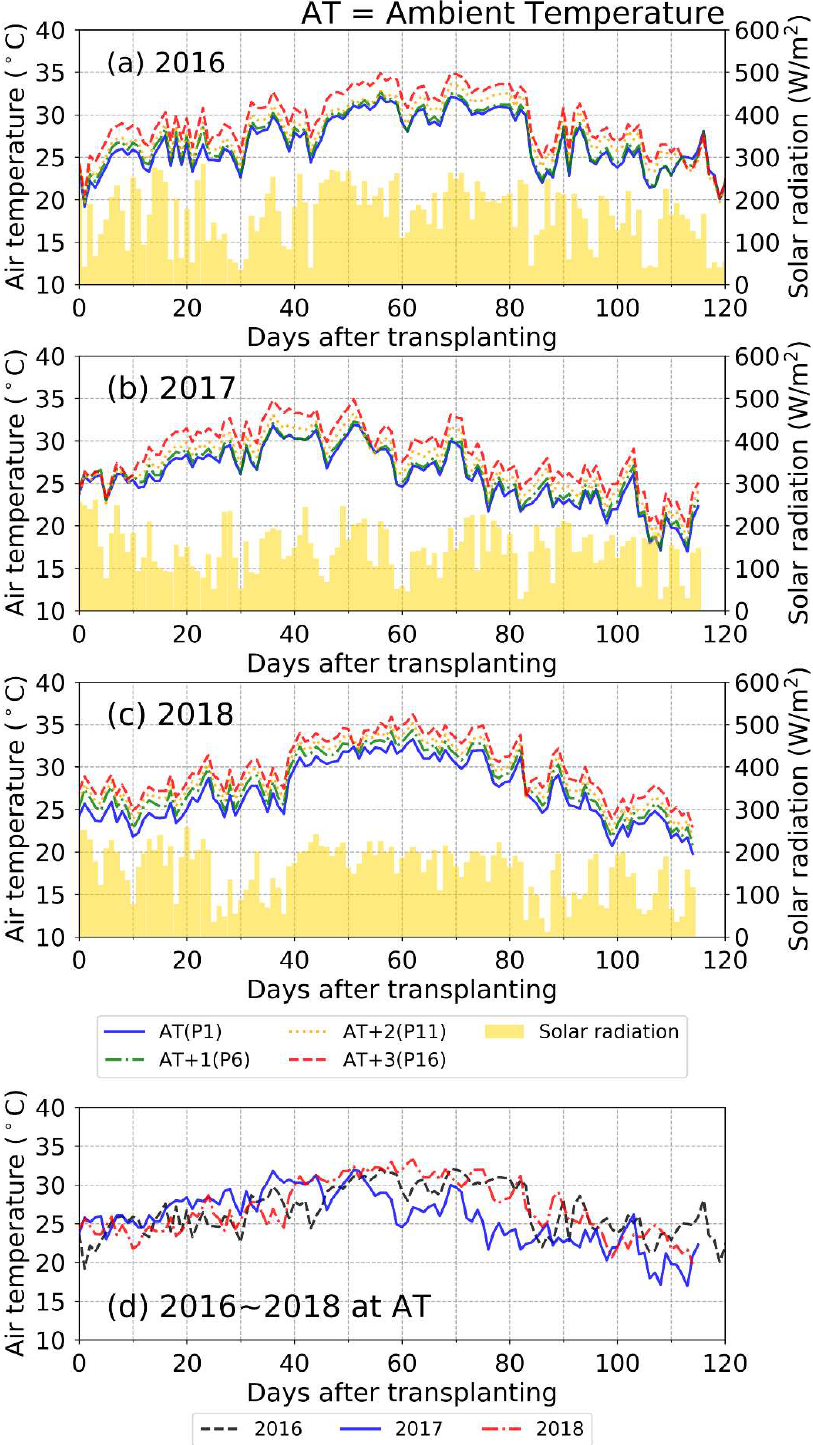
Figure 3. Time series of air temperature and insolation in the temperature gradient field chamber (TGFC) for three years ( a ) 2016 year, ( b ) 2017 year, ( c ) 2018 year, and ( d ) 2016~2018 years. The daily mean air temperature was controlled to maintain values of ambient air temperature (AT), AT+1, AT+2, AT+3 °C in the four positions, which were named as position 1 (P1), position 6 (P6), position 11 (P11), position 16 (P16) in this study.